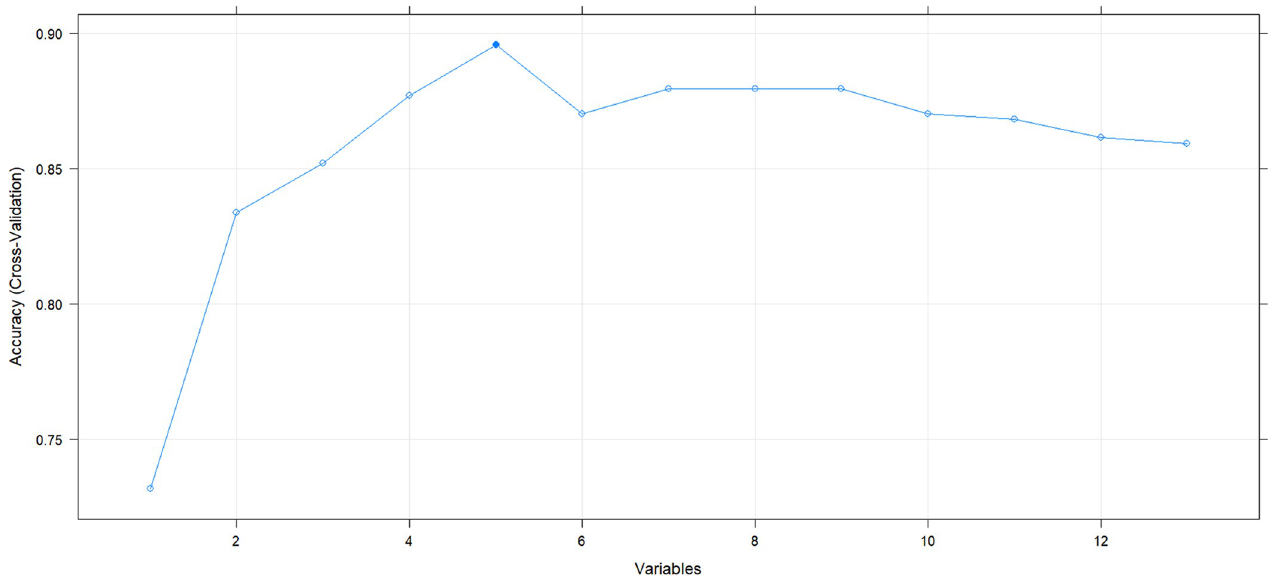
Fig 1. Optimal number of features in RF-models for extremely preterm infants with 23 to 26 WG.